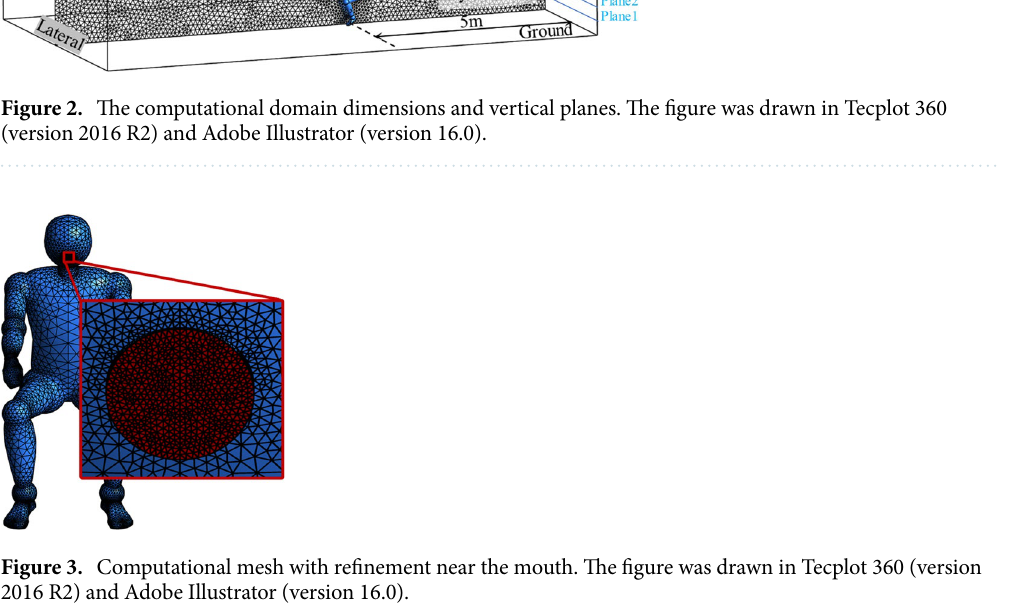
of the infector is modelled as a cone-atomized spray loaded with virus-laden droplets, which are released from the opening mouth 2 cm in diameter 6 . The computational domain is discretized by unstructured tetrahedron grids with an average skewness number of 0.2 and an average surface y+ near 3. Twelves inflation layers with a growth ratio of 1.1 are generated near all wall boundaries to capture detailed velocity and pressure gradient change at the near wall regions. The refinement applied in the vicinity of the mouth is shown in Fig. 3. The num- ber of droplet trajectories was also analyzed. Consistent with the findings of Dudalski 38 and Busco 39 , the angle 27.5 ◦ , and the spreading angle of the coughing between the coughing direction and the horizontal plane is θ = 12.5 ◦ (shown in Fig. 6). The simulated time duration is 60 s with a non-uniform time step for cone spray is α = 0.01 –0.2 s. The time step of the discrete phase is (cid:31) t 5 10 − 3 s 0.01s . The the continuous phase of (cid:31) t = = × ∼ 3D Reynolds-averaged Navier–Stokes (RANS) equations are solved with the boundary conditions and RNG k-e turbulence model through ANSYS Fluent. The Grid Convergence Index (GCI) 40 applied with the Richardson Extrapolation is employed in the grid independence study for the Eulerian phase to estimate the refinement error caused by distinct grid spacing. The space discretization of the domain in half is performed using coarse, medium, and fine meshes of 75, 212, and 597 thousand elements with a linear refinement factor of √ 2 . Figure 4 shows the profiles of the mass-flow averaged pressure, temperature, and velocity at nine cross-section planes (shown in Fig. 2) along the height direction. The values calculated from Richardson extrapolation are the theoretical values of an infinitely fine grid scheme with zero spacing. The GCI is calculated with a safety factor of 1.25 between two grids: GCI 12 considers the change from the fine grid to the medium grid and GCI 23 from the medium grid to the coarse grid. The results show a limited dependence of the mass flow-averaged pressure, velocity, and temperature with the maximum local GCI 23 value of 0.0034%, 0.03%, and 0.0001% at Plane 3 (in Fig. 4a), Plane 1 (in Fig. 4b), and Plane 1 (in Fig. 4c), respectively. For the validation of the Lagrangian model, the total mass of cough droplets over time is calculated to check the mesh independence (in Fig. 5). The results of the medium and fine mesh almost overlap, while the predicted value of the coarse mesh is low. It is concluded that the fine mesh is sufficient to extract quantitative data for both the Eulerian and the Lagrangian phases from the simulation. In Fig. 7, the baseline (Case 1) is conducted as the situation where droplets from a regular cough are spread- ing in an enclosed area. Various precautions, namely, face mask (Case 2), air-applied (Case 3), and protective screen(Case 4), are placed separately to alter the original pattern of cough, further reducing the infection risk. The rest of the cases (Case 5–8) are different combinations thereof, as shown in Table 1. Discrete Phase Model (DPM) 41 integrated with the evaporation model 42 is adopted to calculate the trans- mission and evaporation process of discrete droplet particles under the continuous air ambient. As shown in Table 2, two sets of boundary conditions are considered: the general cases with a quiescent interior ambient can allow droplets to diffuse freely (in Case 1/2/4/7), and the ventilated cases with fresh air transported from upward ventilation can discharge the virus-laden aerosol (in Case 3/5/6/8). The definitions of boundaries in DPM are trap, escape, and reflect. For the “trap” setting, the trajectory calculations are terminated, and the droplets will